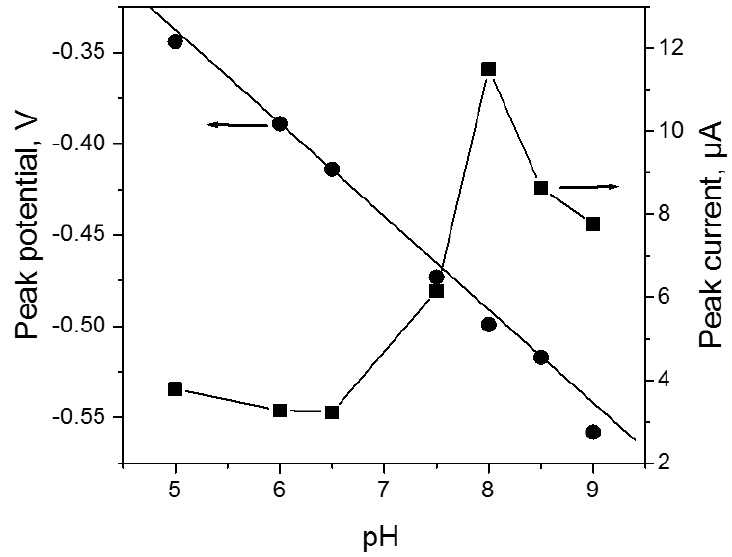
Figure 5. Effect of PBS solution pH on the peak current and peak potential of 10 −6 M NBA at GCE/Lys/HA.